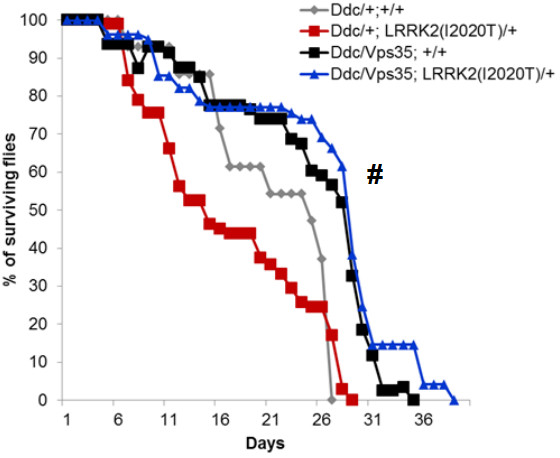
Overexpression of Vps35 in DA neurons rescues the shortened lifespan of LRRK2(I2020T) flies. N = 8-11 cohorts of ten per genotype. All flies were reared at 29°C. Statistical analysis: Two-Way ANOVA, Tukey’s post-test. Statistically significant difference compared to Ddc/+;LRRK2(I2020T)/+is denoted as # for P < 0.05.